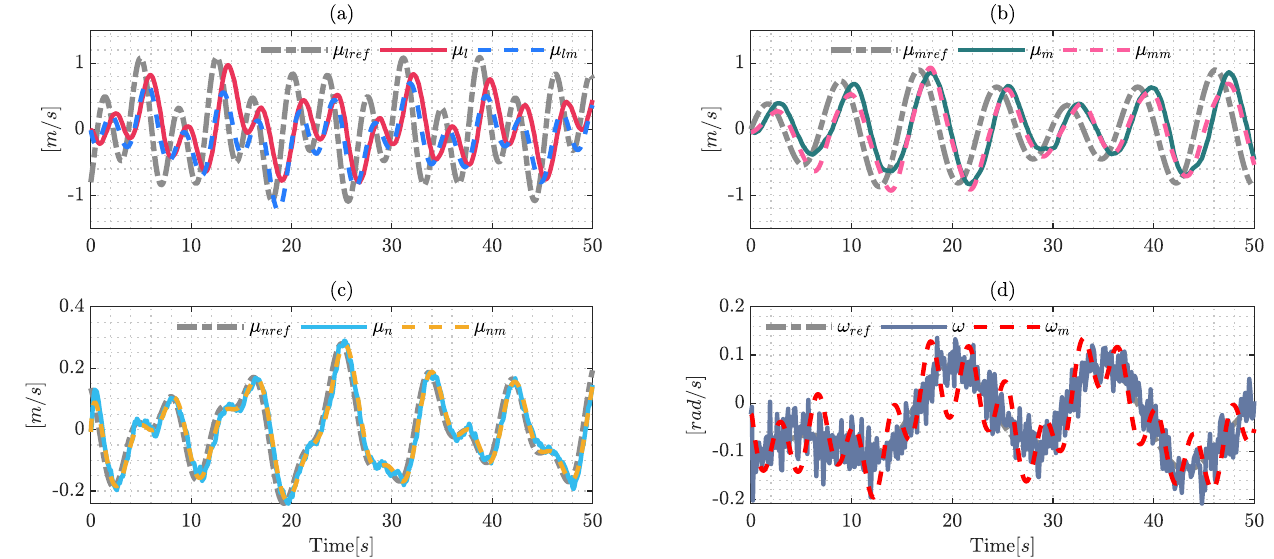
Figure 3. Validation process signals using the Euler–Lagrange formulation with the optimization technique (SQP). The results are confirmed by: ( a ) validation over the reference velocity µ lref ; ( b ) shows the results over the reference velocity µ mref ; ( c ) shows the validation over the longitudinal velocity µ nref ; and ( d ) shows the validation results of the reference angular velocity ω ref